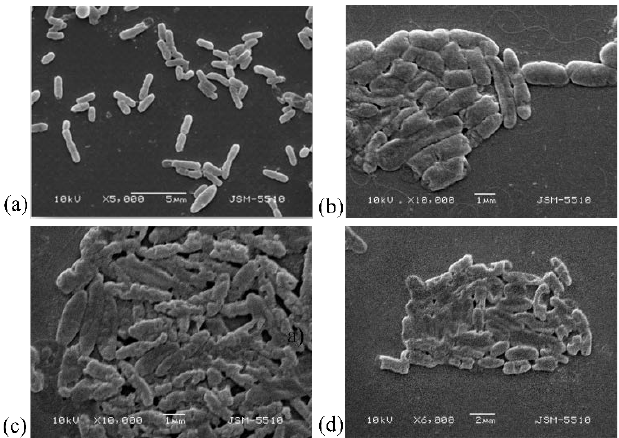
Figure 6. SEM analysis of cells of E. coli NBIMCC 8785 influenced with 50% peptide fraction (MW < 10 kDa): ( a , b )—control 48 h bacterial culture at 5000× and 10,000× magnification; ( c , d ) damaged bacterial cells of E. coli NBIMCC 8785 after action of the peptide fraction.